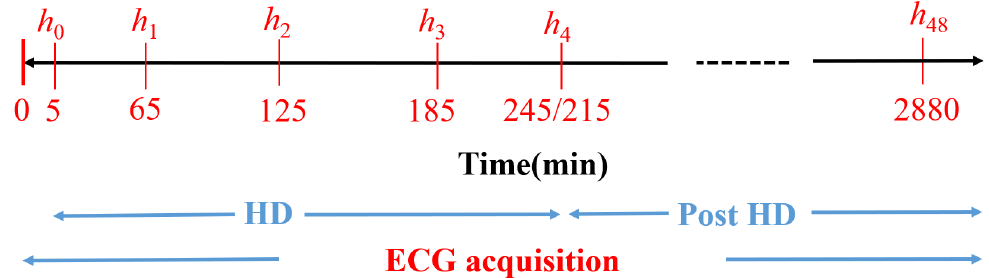
Figure 1. Diagram of the study protocol. h 0 to h 48 are the time points (in minutes) for blood sample extraction. Reproduced with permission from Bukhari et al., Computers in Biology and Medicine; published by Elsevier, 2022. Table 1. Characteristics of the study population. Values are expressed as number (%) for categor- ical variables and median (interquartile range, IQR) for continuous variables. Reproduced with permission from Bukhari et al., Computers in Biology and Medicine; published by Elsevier, 2022.